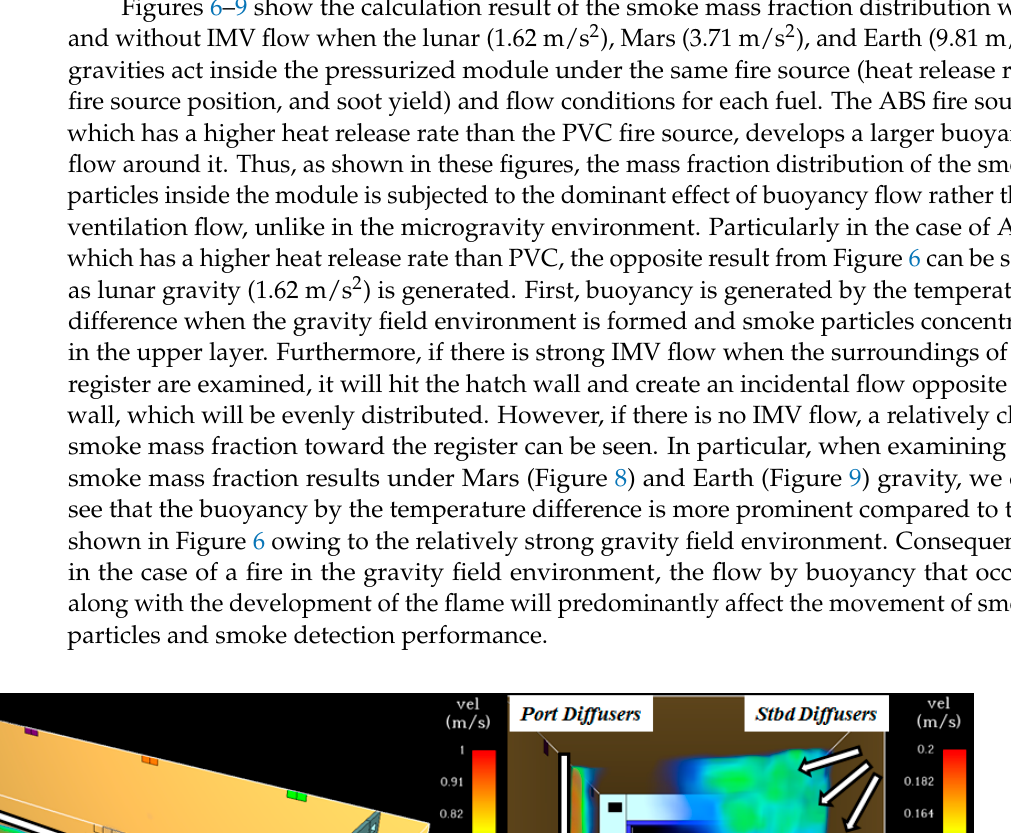
Figure 4. Sensitivity analysis of soot mass fraction calculated with different sizes of the mesh cell.